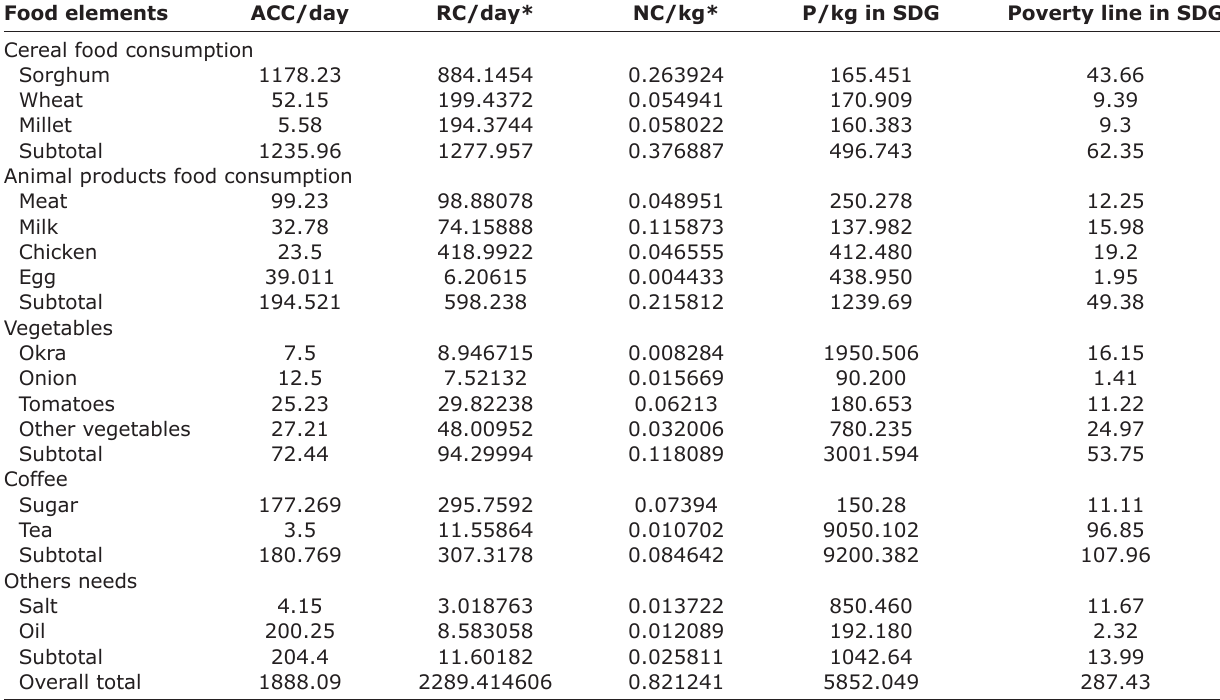
Table-1: Food consumption of households in Bahri region. Food